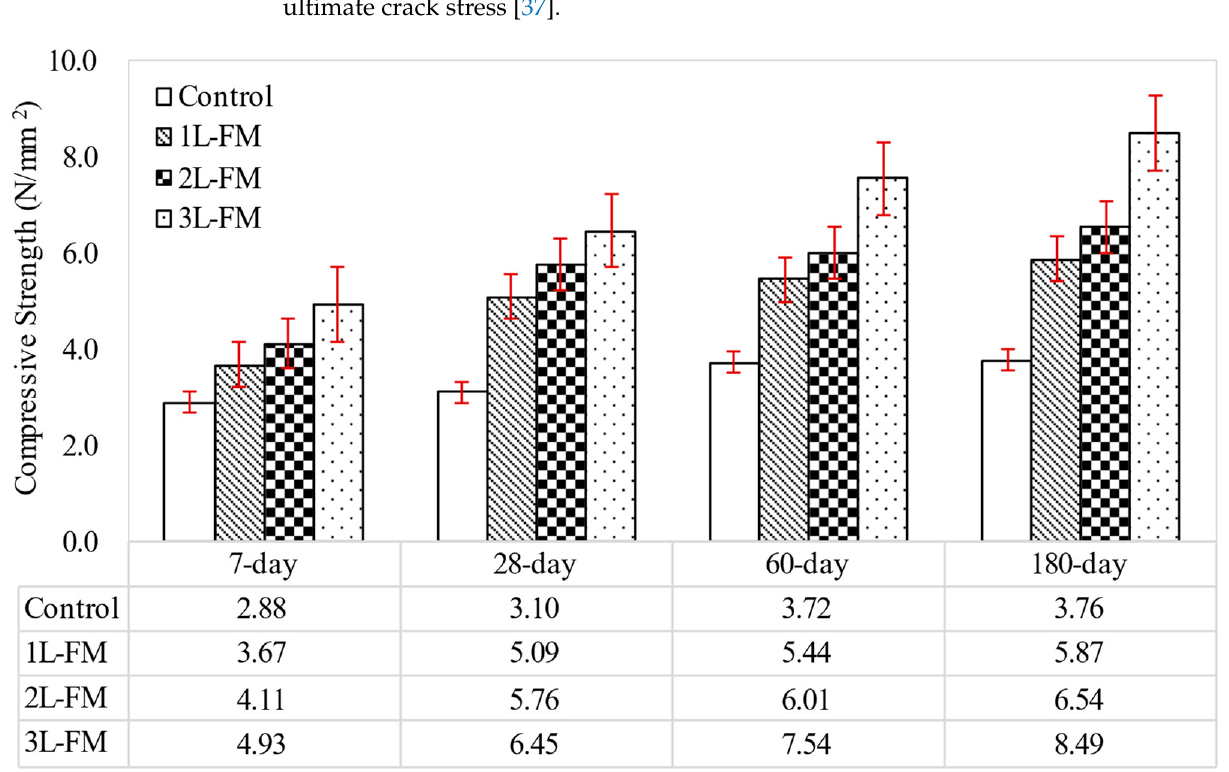
Figure 7. Compressive strength of foamcrete with different layers of FM.